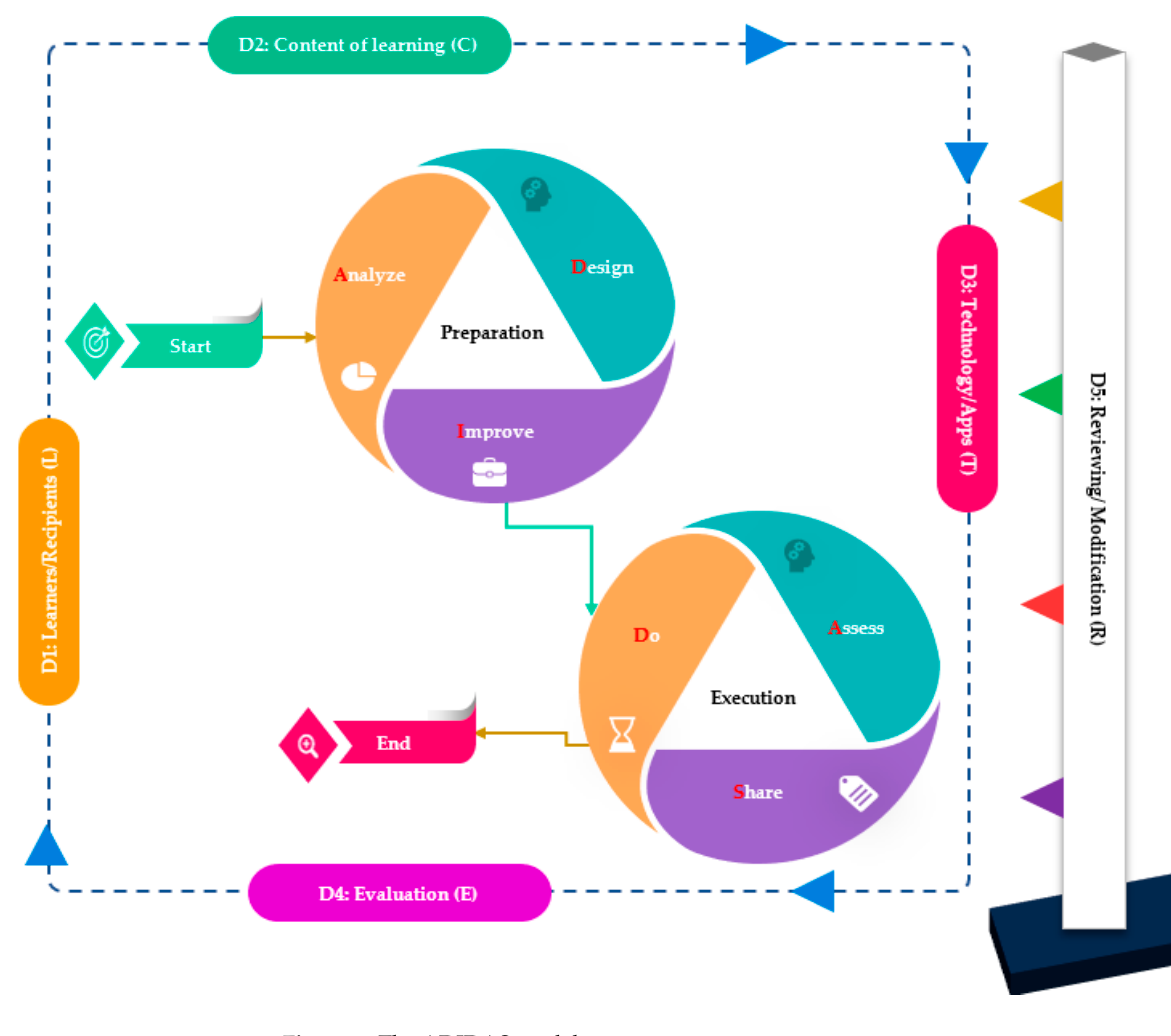
Figure 1. The ADIDAS model.